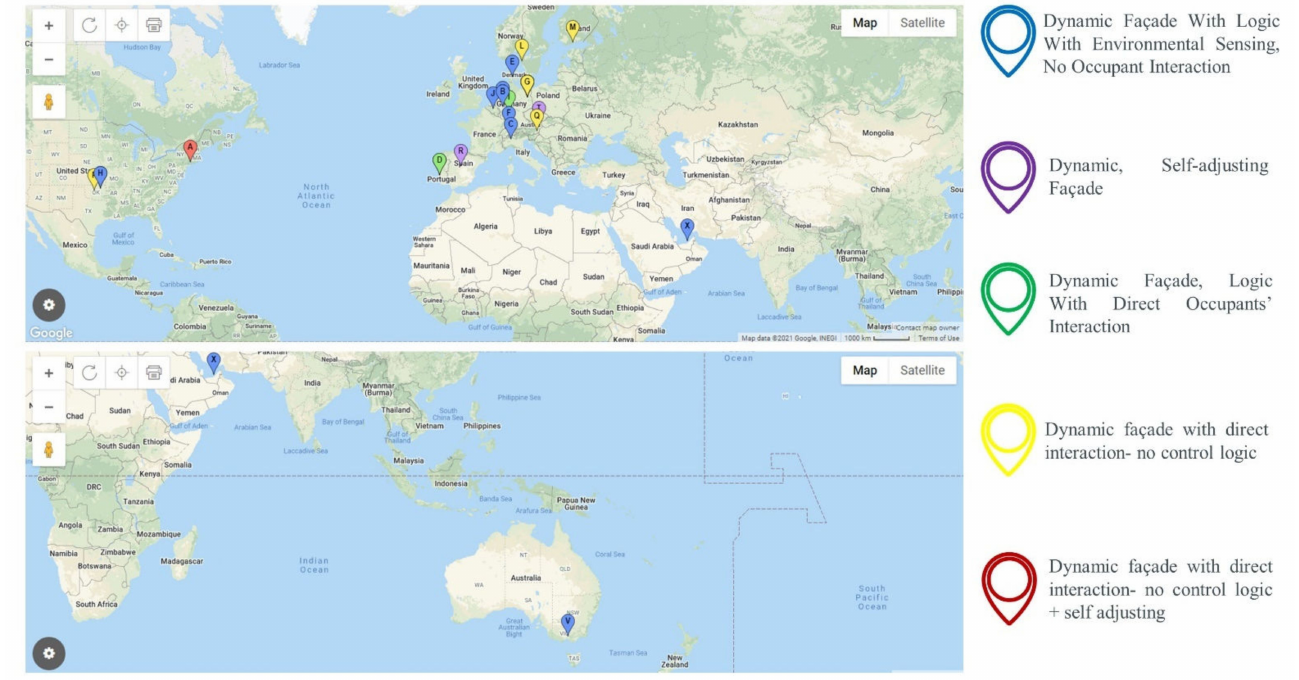
Figure 8. Location of CABS office buildings based on the user–façade categories (retrieved from https://Batchgeo.Com/Map/A7be91e654bf328a43b5eb0f7f2fd389). (Accessed on 16 December 2021).